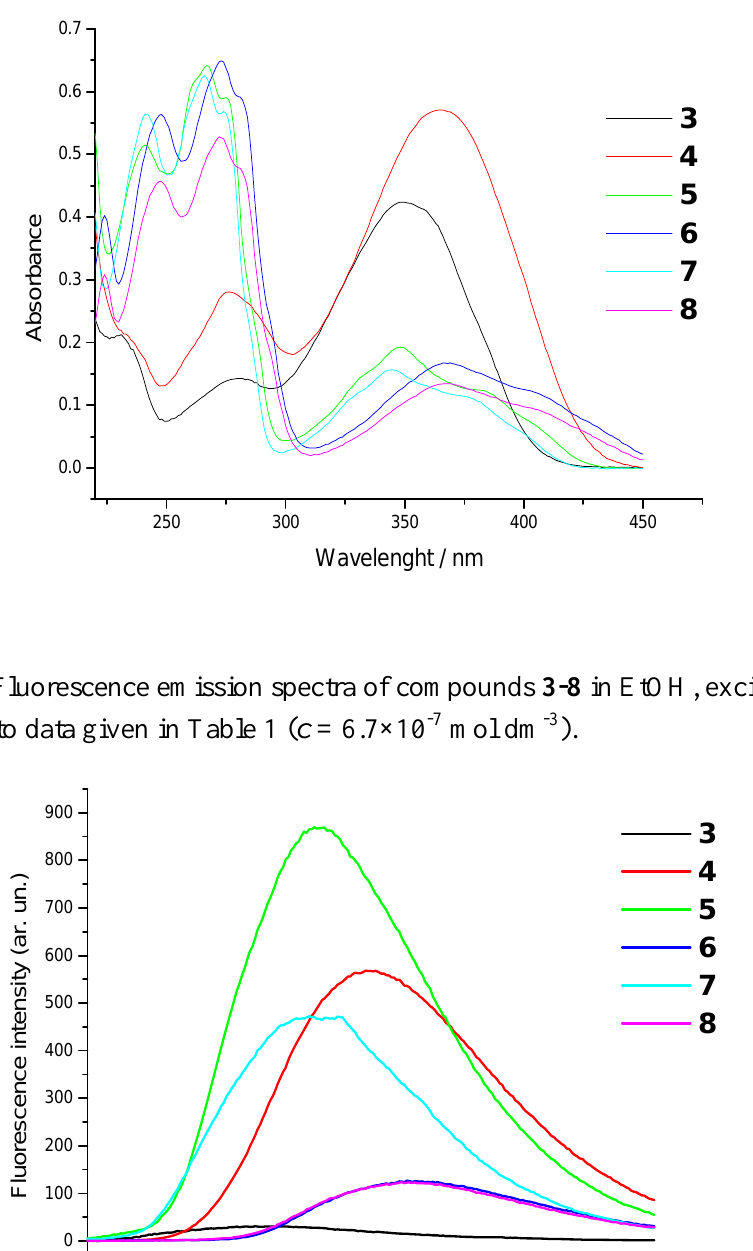
Figure 1. UV/Vis absorption spectra of compounds 3-8 in EtOH ( c = 2×10 -5 mol dm -3 ).